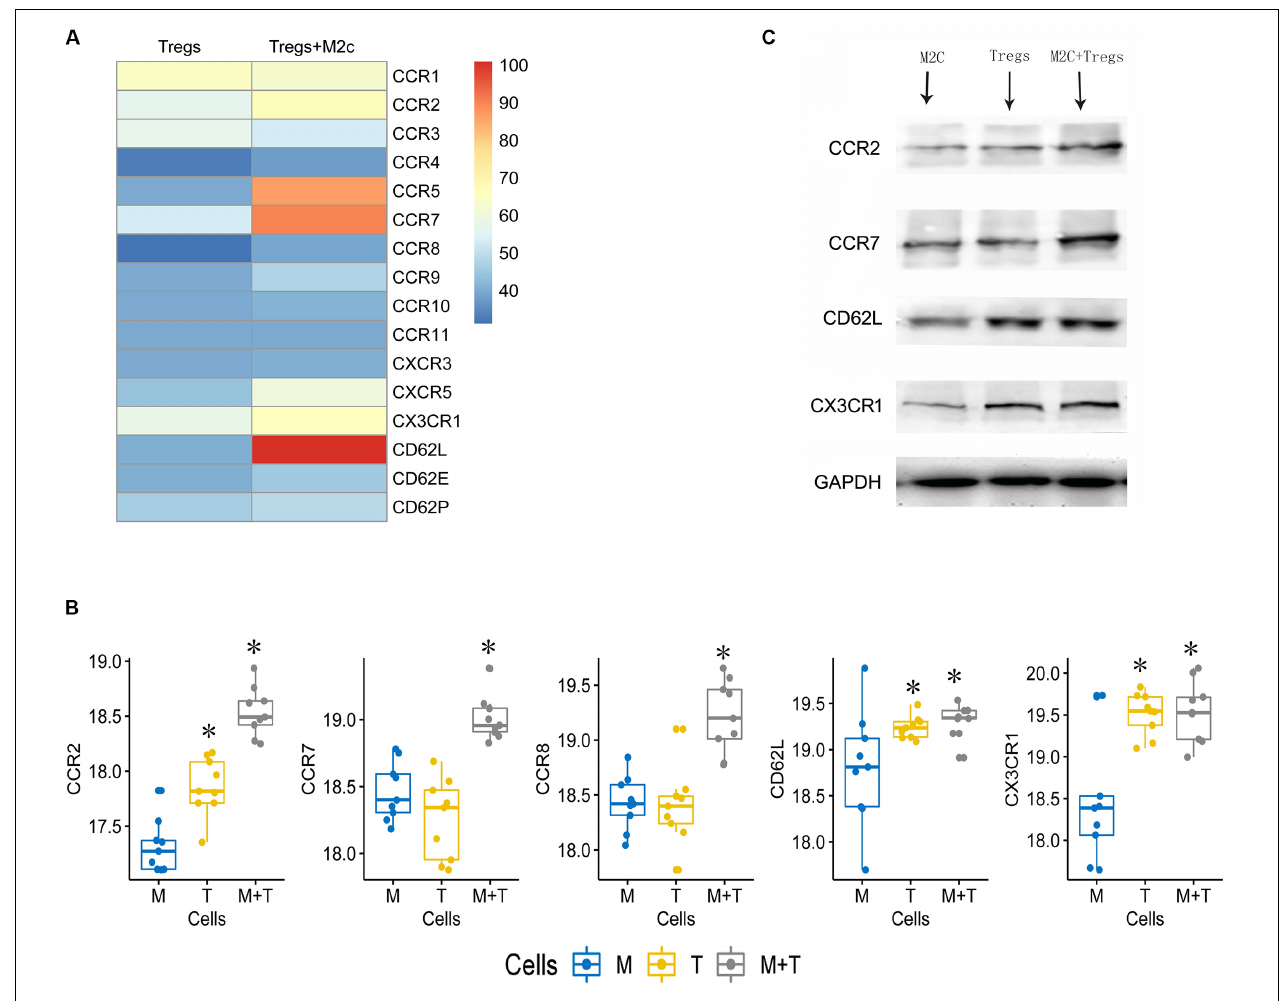
FIGURE 6 | (A) Heatmap showing expression of 16 chemokines in Tregs cultured alone or together with M2c macrophages. (B,C) Western blot validation of the chemokine up-regulation observed in panel. M, M2c macrophages; T, regulatory T cells. * P < 0.05 versus M2c